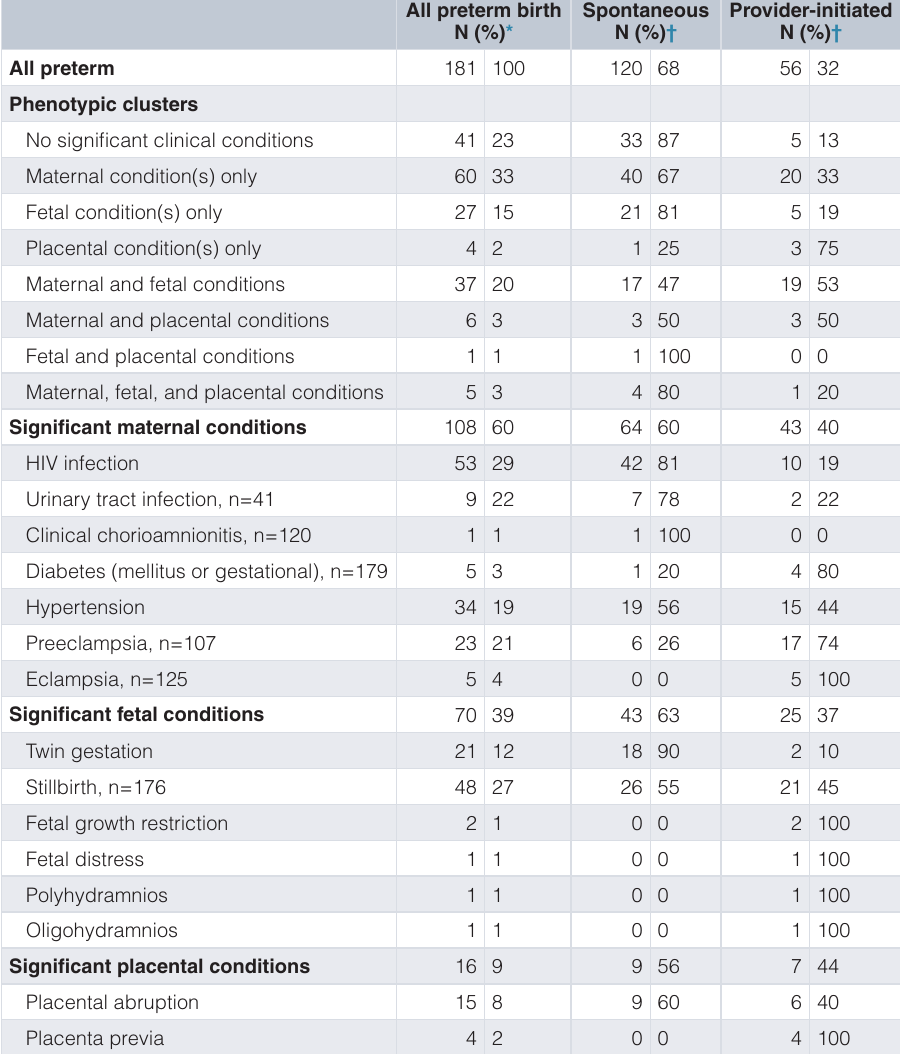
Table 2. Phenotypes of preterm birth in ZAPPS cohort,